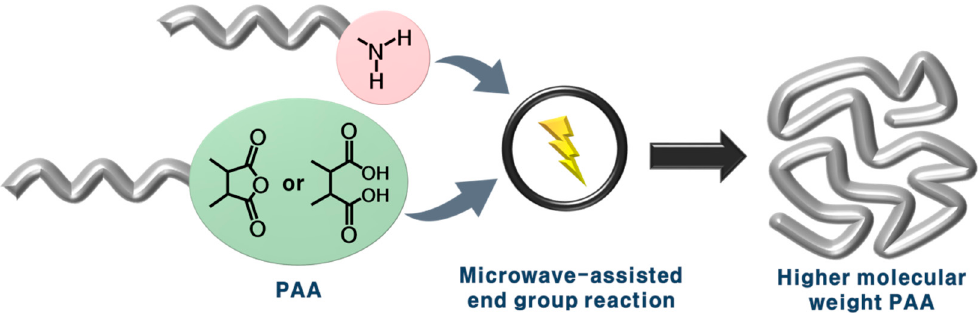
Figure 5. Schematic illustration of the MW-assisted end group reaction that forms higher-molecular-weight PAA.